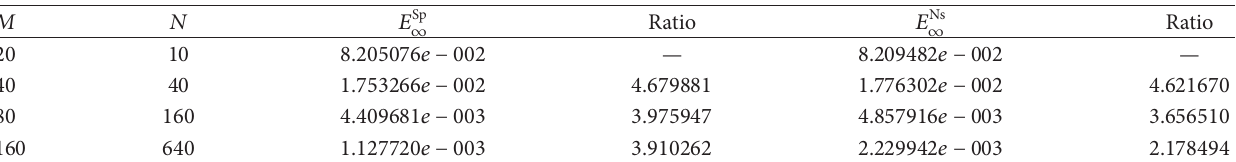
Table 2: Convergence results for the scheme (45) and the nonstandard scheme proposed in [16] for the transaction costs model together with a butterfly spread, where 𝑎 = 0.05 .